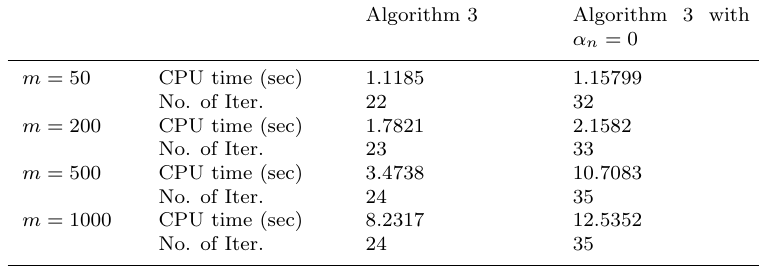
Table 1. Computation results for Example 1.